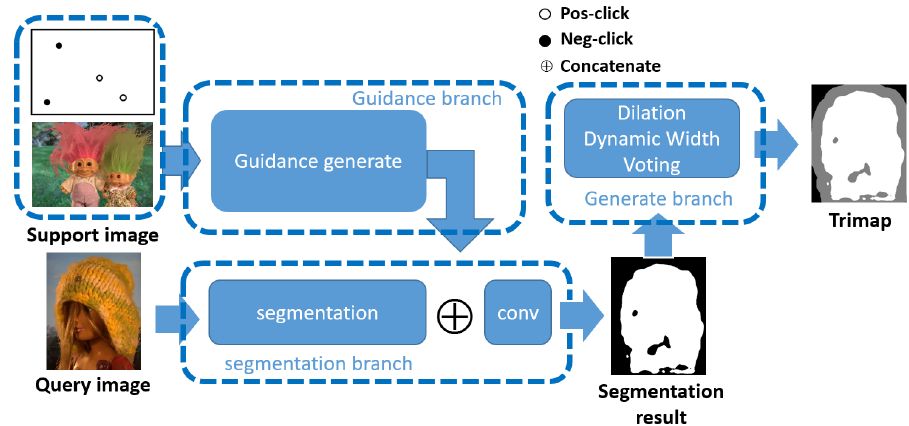
Figure 2. Proposed model